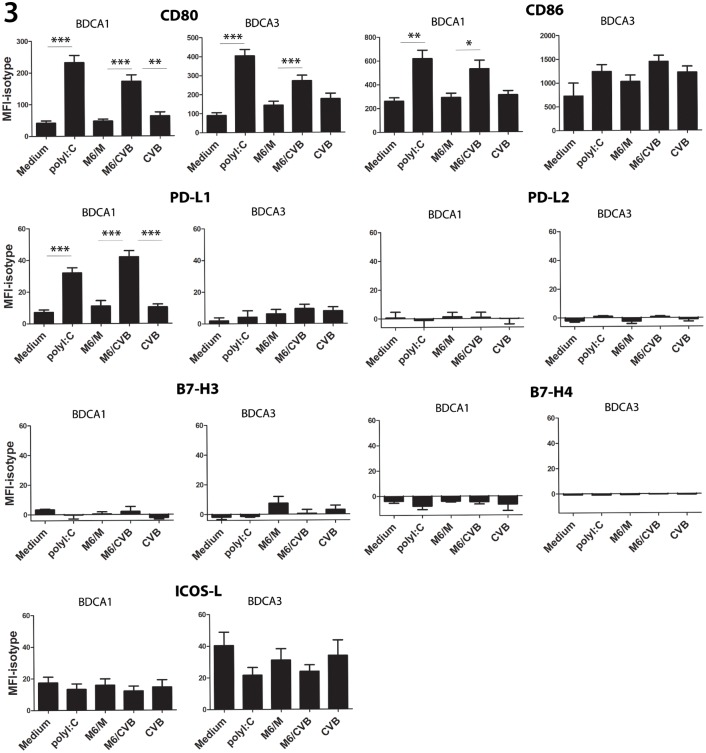
Phagocytosis of CVB-infected Min6 cells results in upregulation of co-stimulatory markers in BDCA1+ mDC and BDCA3+ mDC, and co-inhibitory marker PD-L1 in BDCA1+ mDCS.DCs were stimulated o/n as in Fig. 2A and subsequently analyzed for expression of indicated cell surface markers using flow cytometry. Shown are averages of mean fluorescence intensity (MFI)-isotype values of >3 donors + SEM. * p<0.05, ** p<0.01 determined by ANOVA and post-hoc Tukey test.